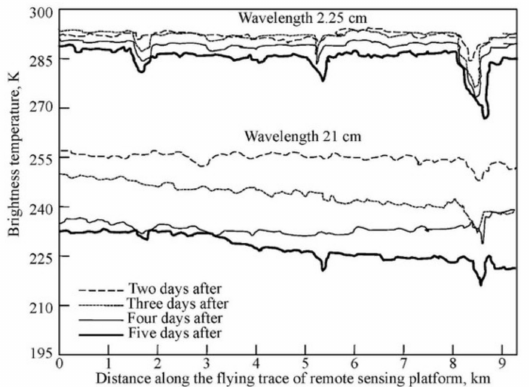
Figure 1. Dependence of the brightness temperature, measured by two radiometers of the manned flying platform IL-18 at 1.43 and 13.3 GHz, on the soil-litter moisture after rainfall